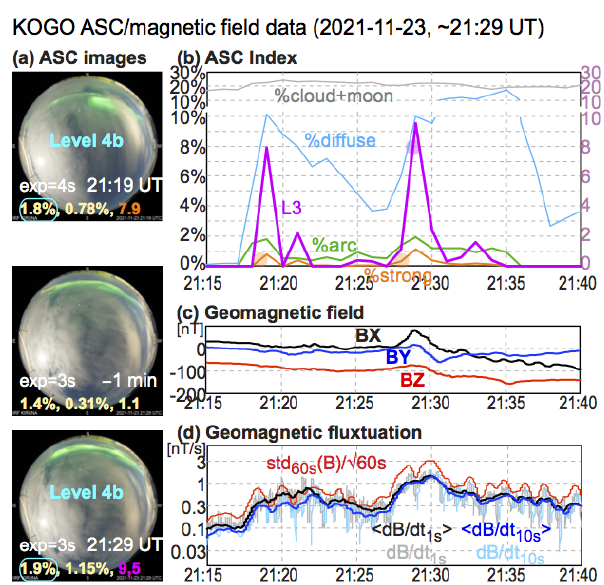
Figure 13. The same as Fig. 8 for the Level 4b auroral activity in the north at 21:29UT on 23 November